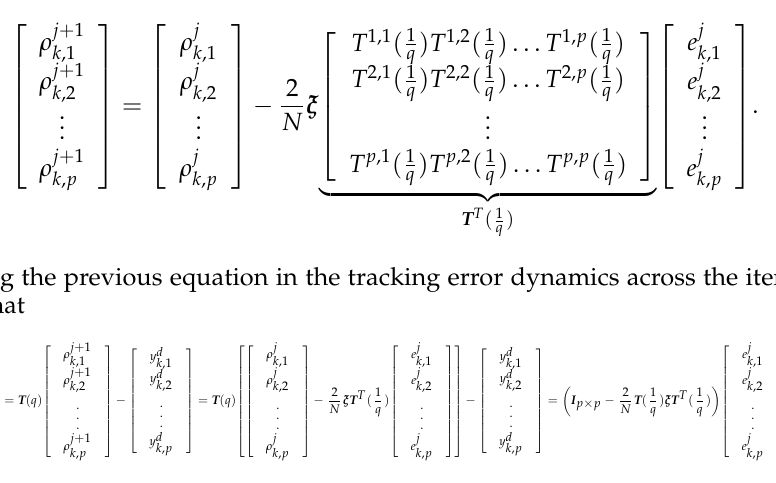
where the frequency domain properties of (cid:107) I p × p − 2 convergence